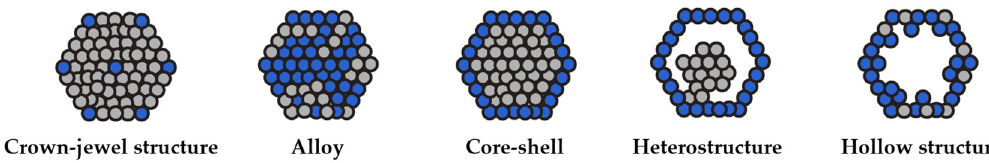
Figure 1. Schematic illustration of bimetallic nanoparticles with different structures.